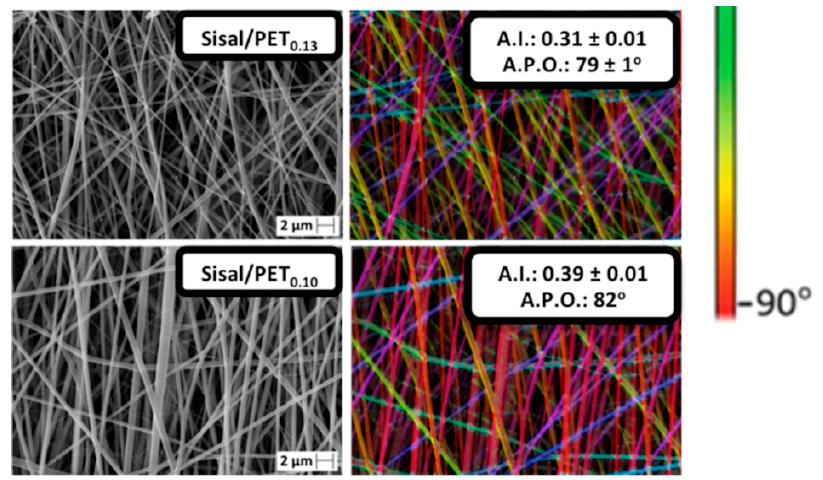
Figure 3. SEM micrographs of the electrospun mats and their respective color-coded images, alignment index ( AI ) and average preferred orientation ( APO ) of the fibers.